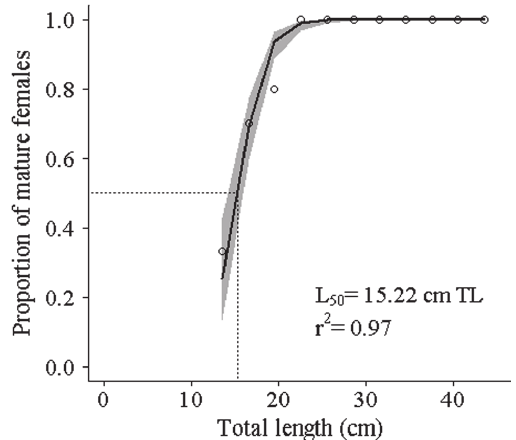
Fig. 5. Proportion of mature females per 3-cm length classes of Pinguipes brasilianus . Shaded areas represent 95% confidence regions and dotted lines indicate length at 50% maturity (L ). 50